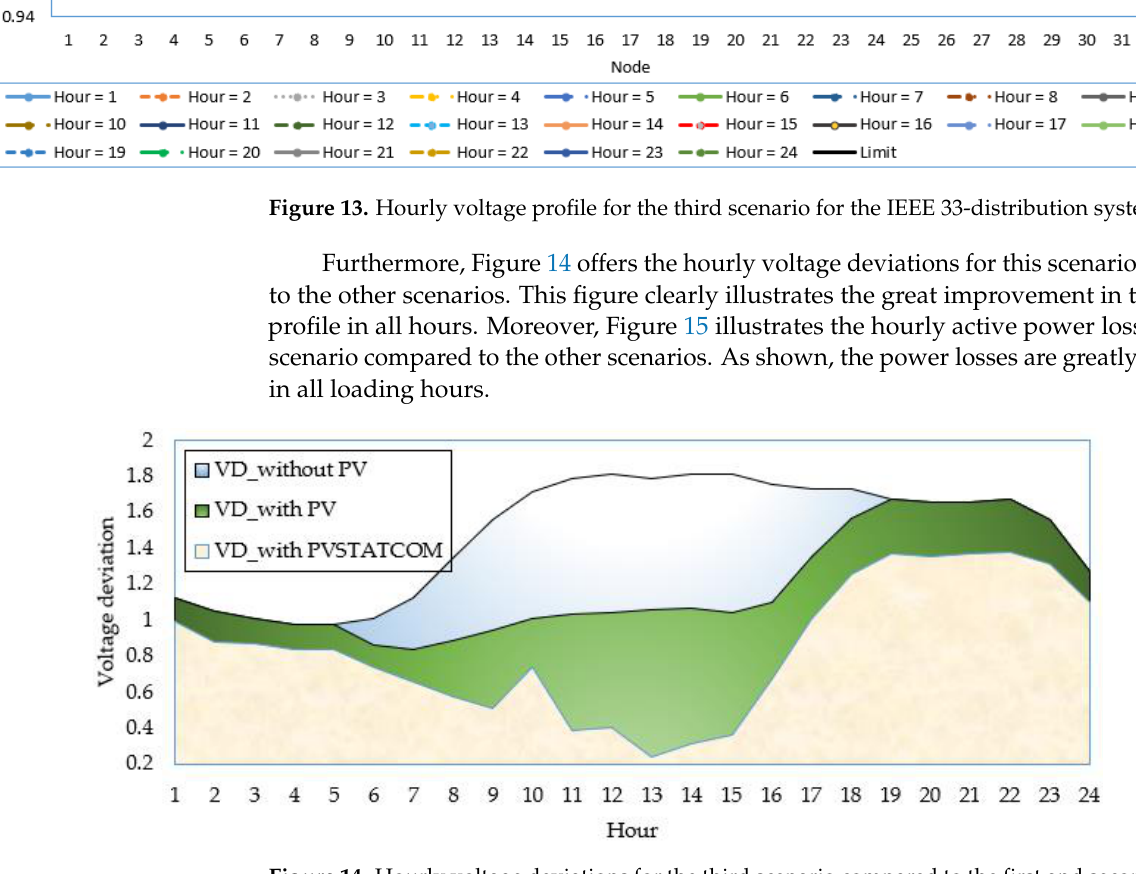
Figure 14. Hourly voltage deviations for the third scenario compared to the first and second scenarios for the IEEE 33-distribution system.